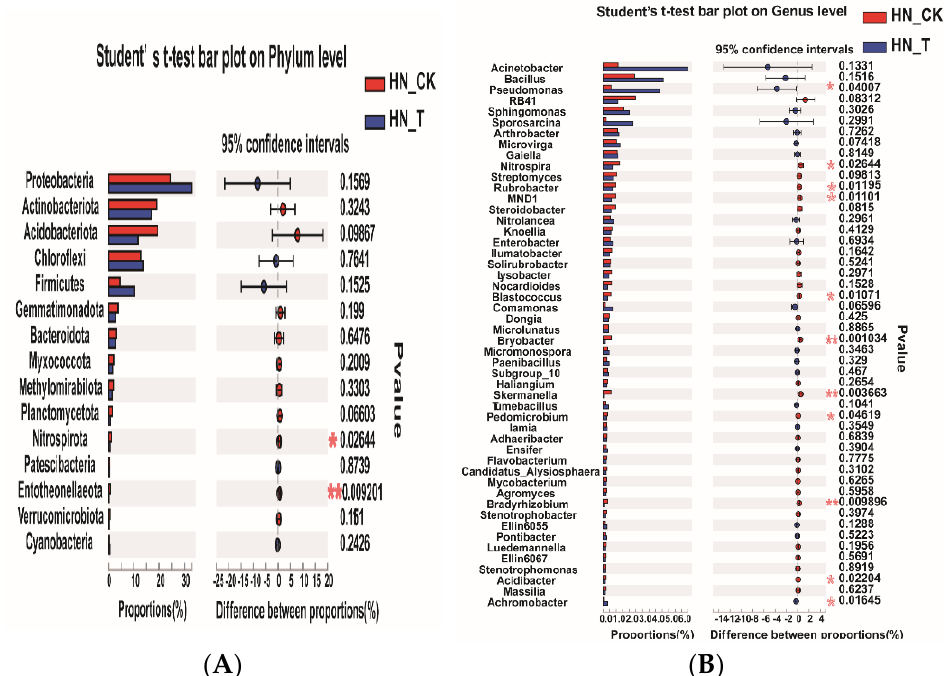
Figure 10. Changes in the relative abundance of bacterial ( A ) phyla and ( B ) genera in triple-fumigated soil that had been used to produce ginger. ‘Triple fumigation’ refers to the simultaneous application of chloropicrin, dimethyl disulfide and metham sodium. The t -test reported the statistical differences (asterisked, * 0.01 < p ≤ 0.05; ** 0.001 < p ≤ 0.01) between the means of three replicates within the phylum or genus levels.